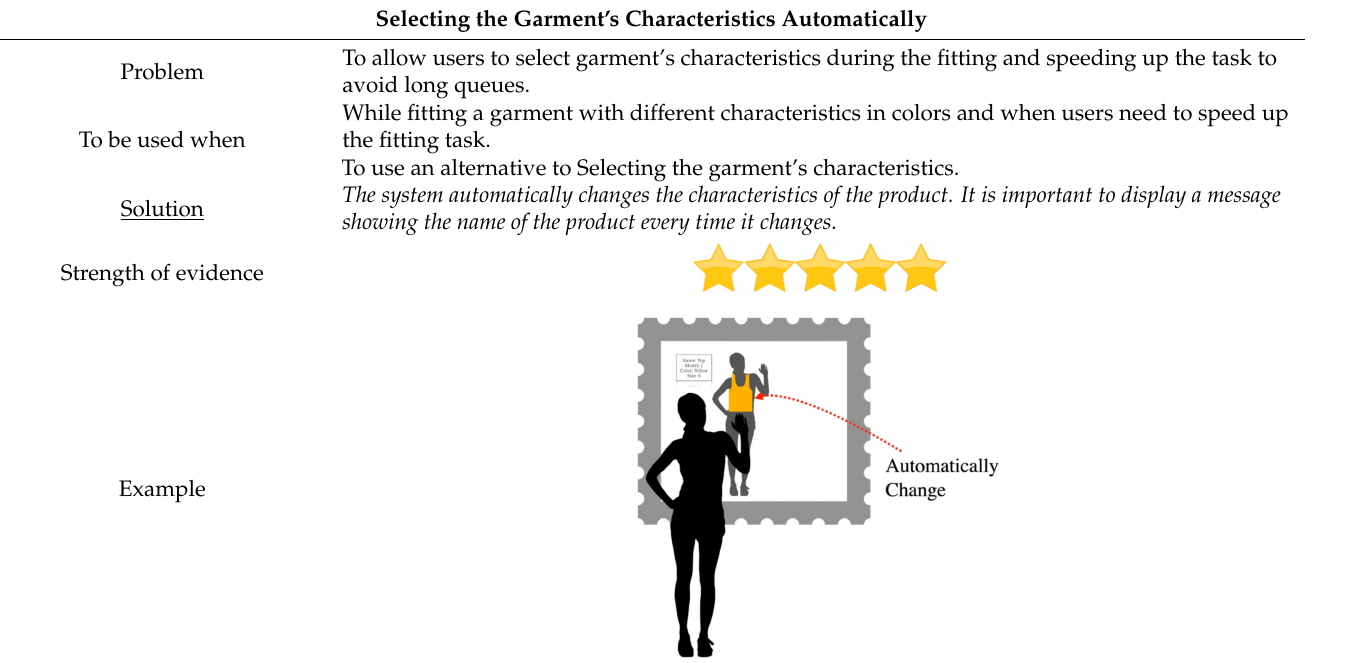
Table 6. Selecting the garment’s characteristics